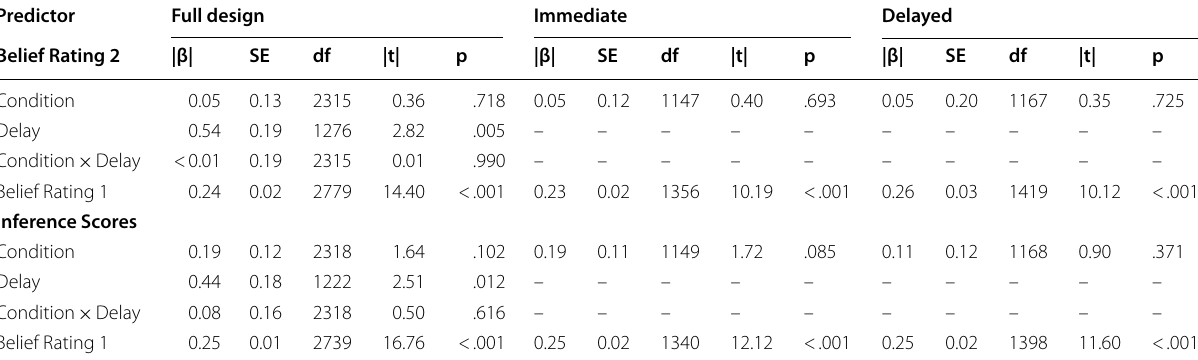
Table 4 Linear mixed-effects modeling results in Experiment 2 Predictor Full design Immediate